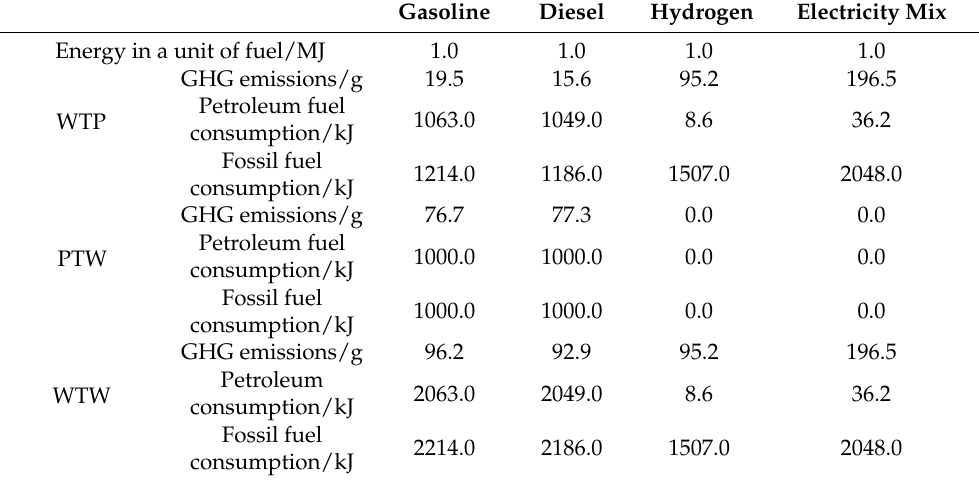
Table 1. Fuel-based WTW